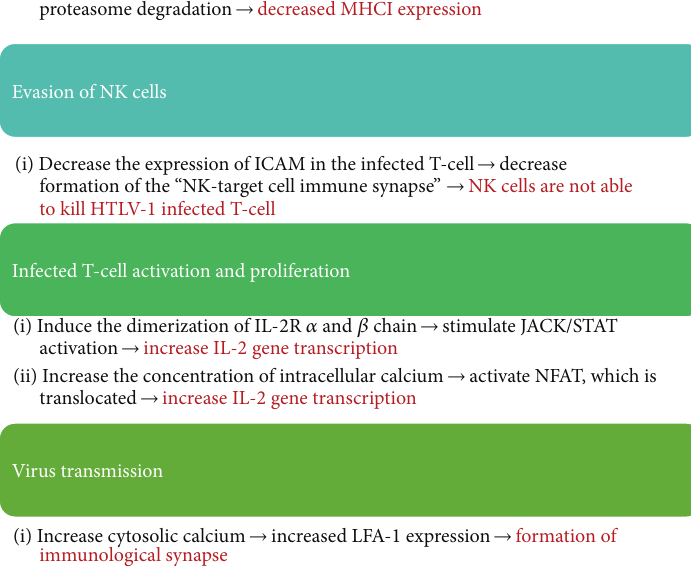
Figure 1: Summary of the host cell alterations induced by HTLV-1 ORF-I encoded proteins and their consequences.